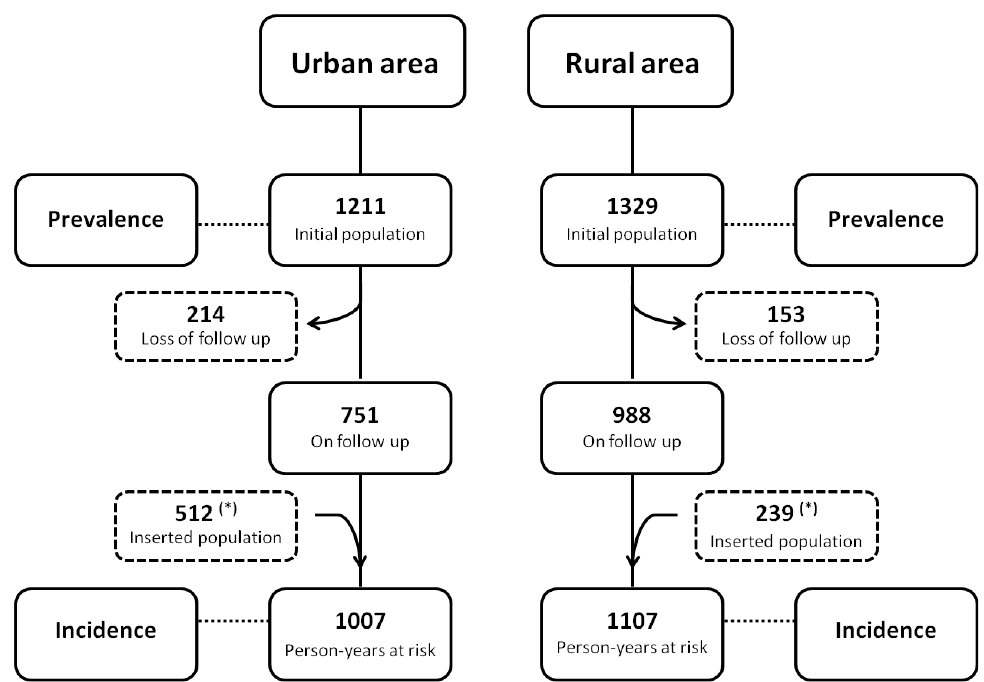
Figure 2. Study population dynamics and study design used to survey prevalence and incidence rates of human L. (L.) infantum chagasi -infection in two distinct epidemiological scenarios in the Brazilian Amazon: the urban area of Conceição do Araguaia municipality and the rural area of Bujaru municipality, Pará State. (*) Individuals who took part in the second stage of the study (incidence survey) as person-years at risk (0.5 person-years at risk).